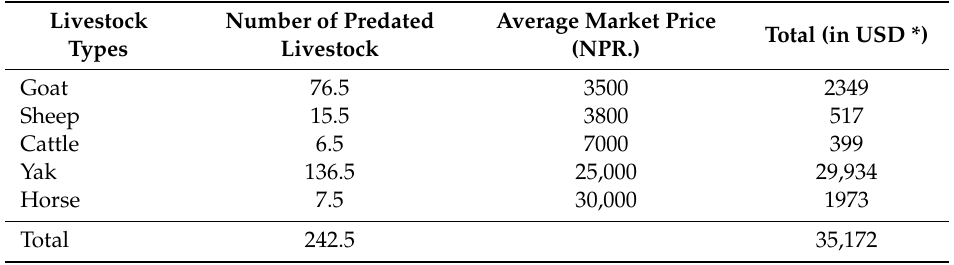
Table 2. Estimated economic loss due to snow leopards for the sampled households ( n = 65) for years 2017/18 and 2018/19.